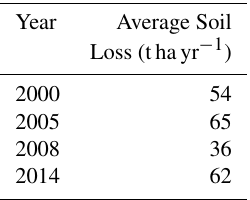
Table 2. Temporal Variation of Estimated Soil